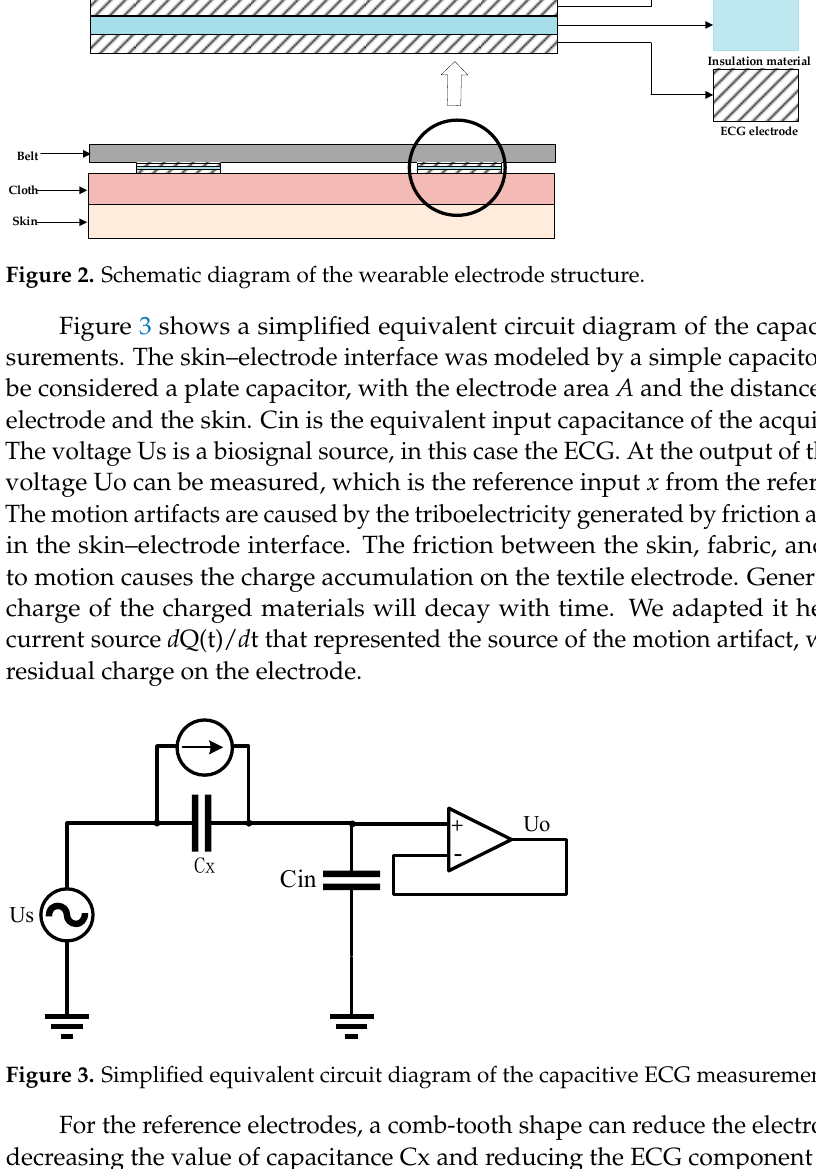
Figure 3. Simplified equivalent circuit diagram of the capacitive ECG measurements.